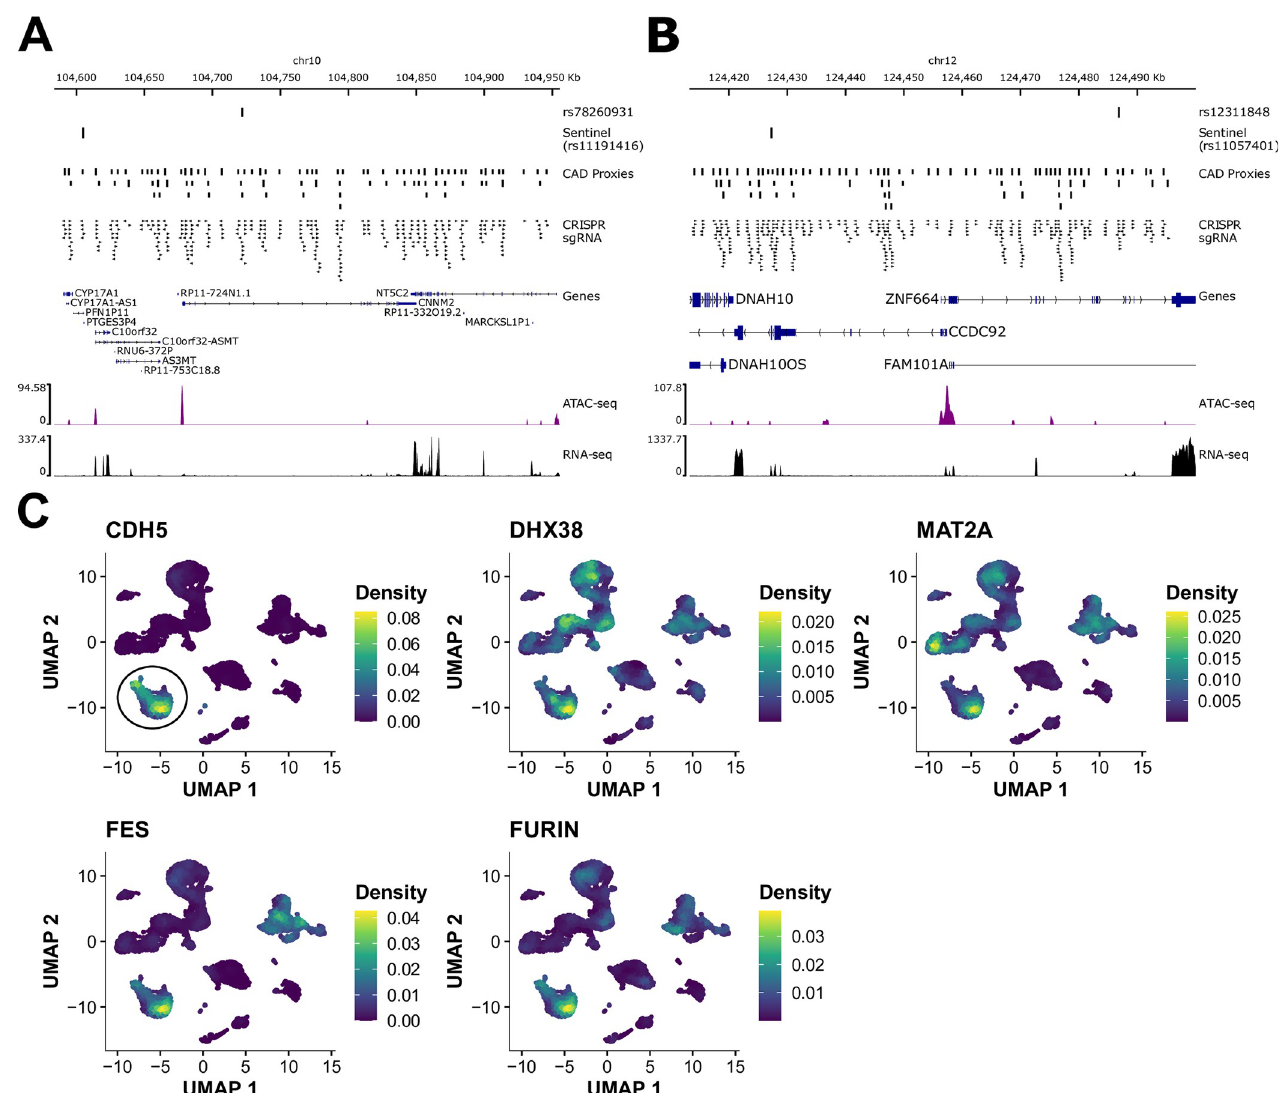
Fig 6. Validated CRISPRa effect at the CNNM2 and CCDC92 / ZNF664 loci do not nominate candidate causal CAD genes. (A) Locus view for the CAD locus with nearby gene CNNM2 . We provide the position of the sentinel CAD variant (rs11191416) and the putative functional variant identified in the pooled CRISPR screen (rs78260931). The LD proxies and sgRNAs tested are also shown. ATAC-seq and RNA-seq data in resting teloHAEC are from ref. [7]. ( B ) Locus view for the CAD locus with nearby genes ZNF664 and CCDC92 . We provide the position of the sentinel CAD variant (rs11057401) and the functional variant identified in the pooled CRISPR screen (rs12311848). The LD proxies and sgRNAs tested are also shown. ATAC-seq and RNA-seq data in resting teloHAEC are from ref. [7]. ( C ) Uniform manifold approximation projection (UMAP) for 11,756 cells from human right coronary arteries analyzed by single- cell RNA-sequencing [36]. We color-coded cells based on the level of expression of candidate causal CAD genes identified and characterized in this study. We used the expression of the endothelial cell marker gene CDH5 (encoding VE-Cadherin) to identify endothelial cells (circle in top left panel). All five candidate genes are expressed in human vascular endothelial cells from coronary